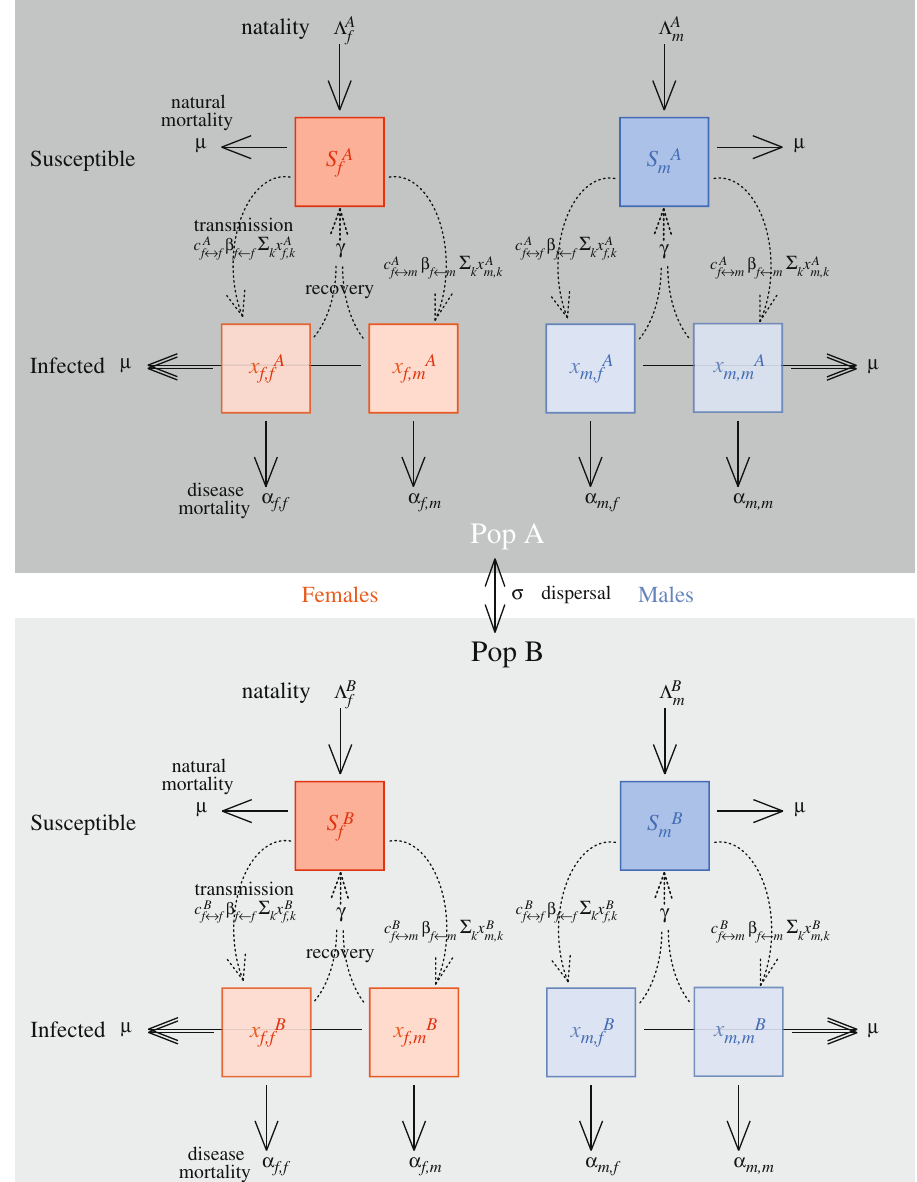
Fig. 3 Flow diagram of two subpopulation epidemiological model. More details can be found in the main text and Note 1 of the Supplementary